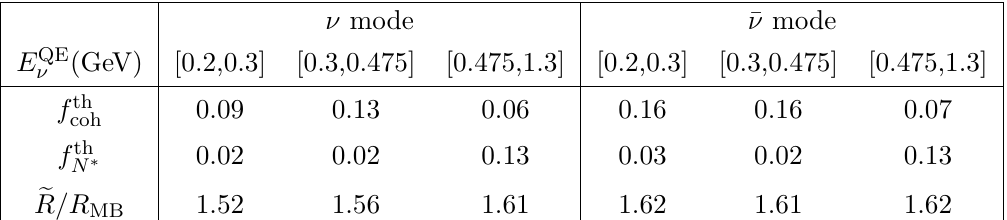
Table 1 . Estimations of f th neutrino energy E QE